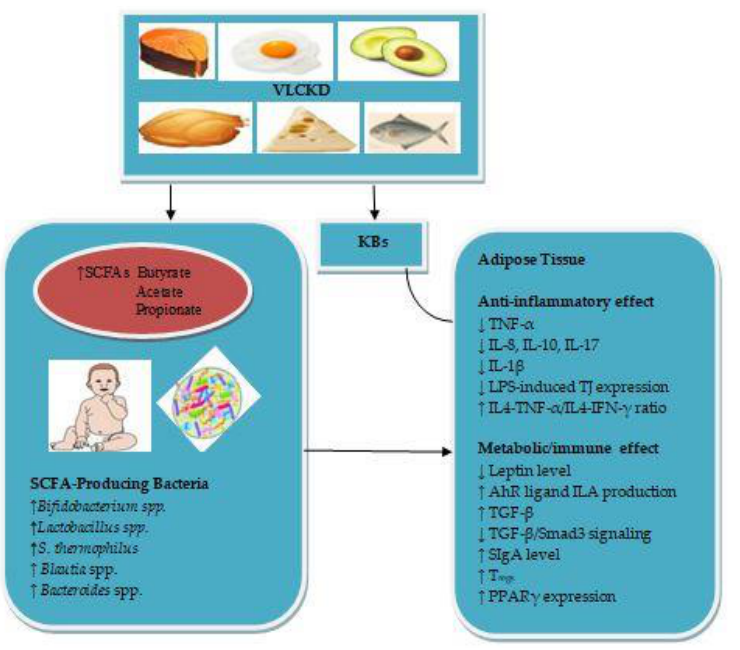
Figure 1. Prevention mechanism of Obesity.